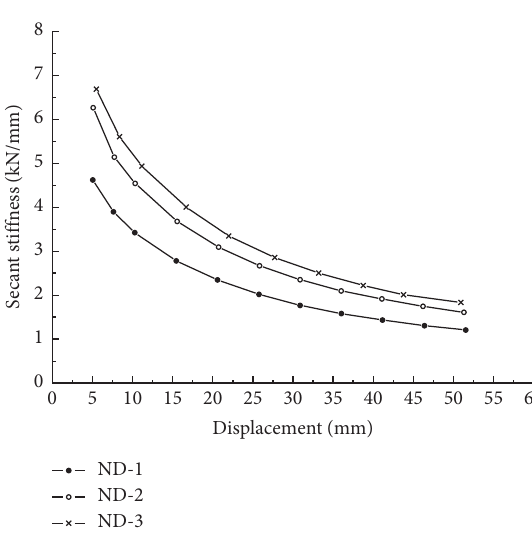
Figure 19: Stiffness curves of slit width 5mm.